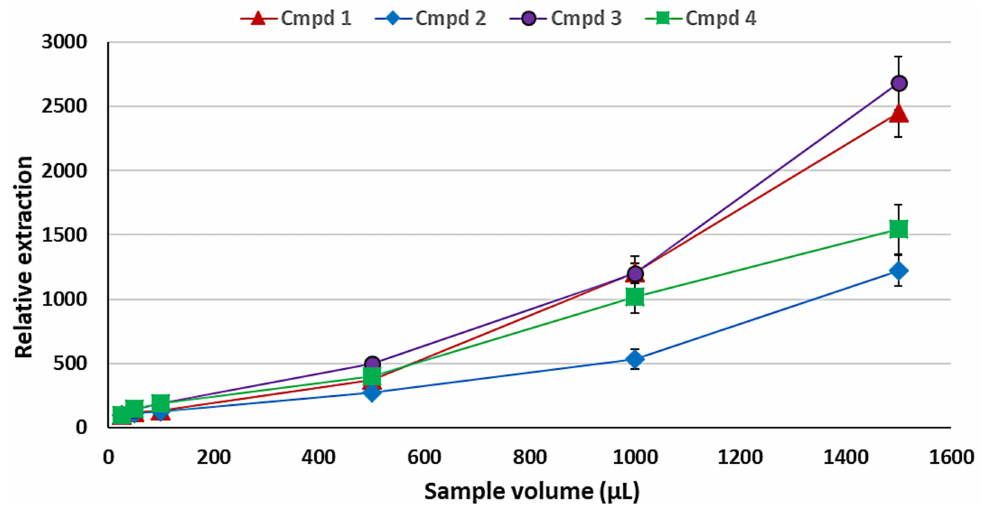
Figure 5. Effect of varying sample volumes (25–1500 µ L) on the SDME using 2 µ L of heptadecane with 15 min equilibration at 55 ◦ C. The error bars indicate the standard deviation for n = 3 replicates.